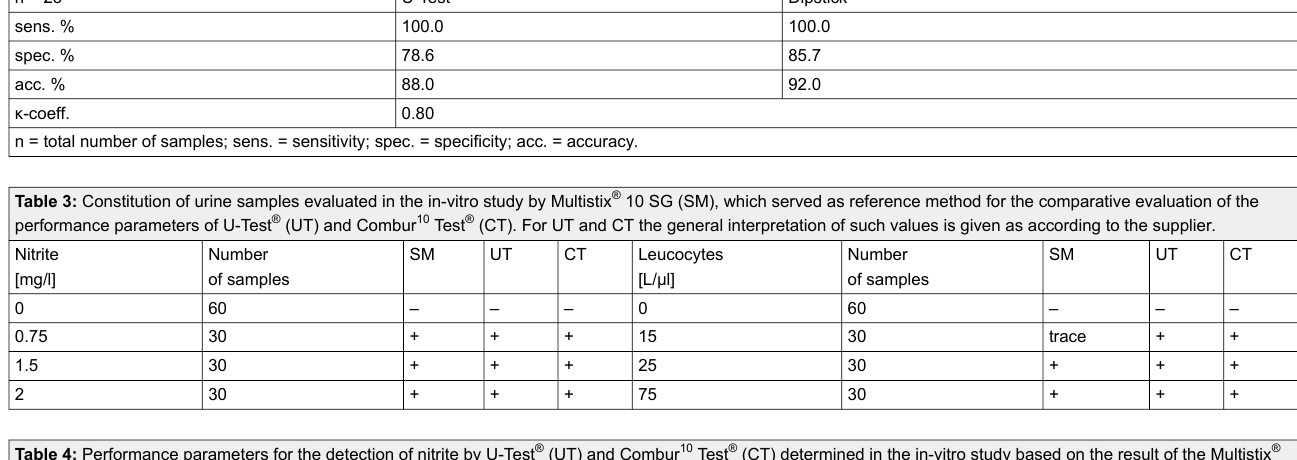
sens. % acc. % κ-coeff.